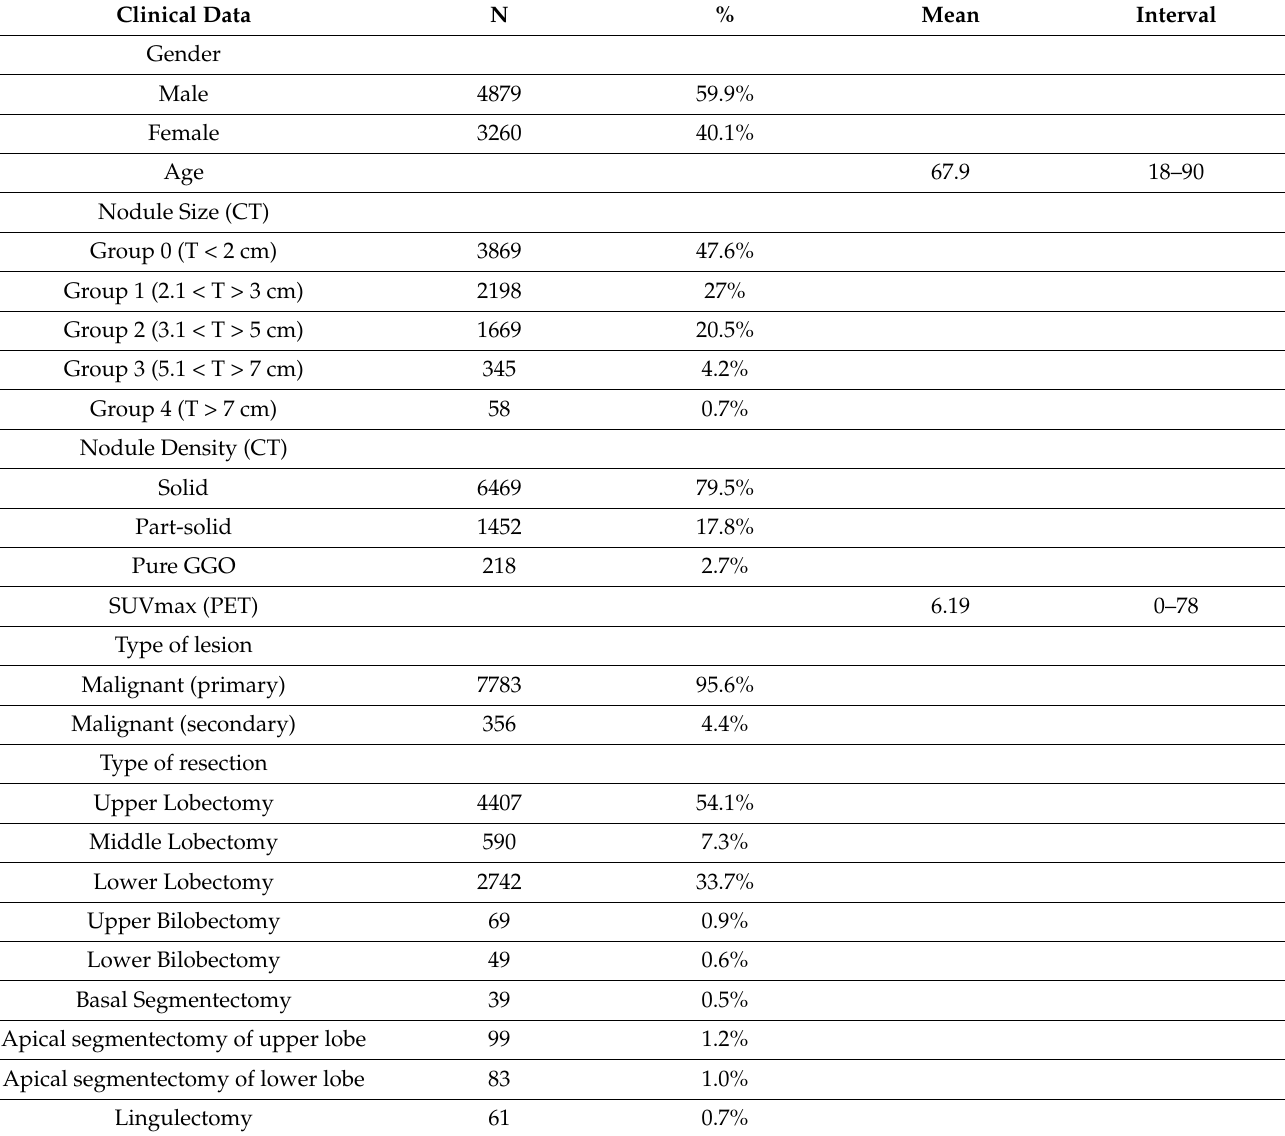
Table 1. Demographics, radiological and pathological